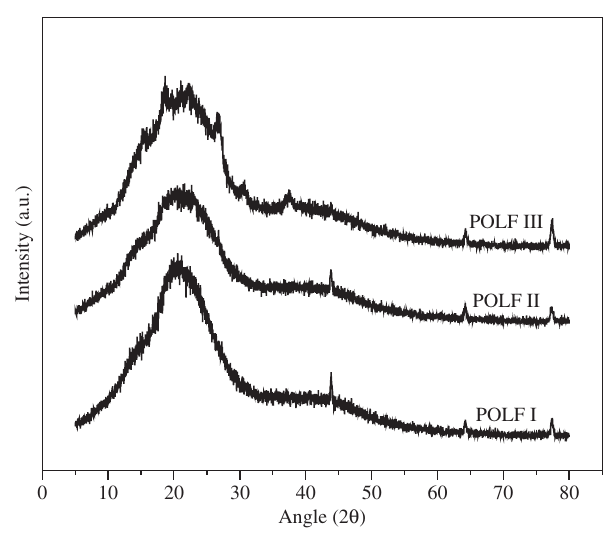
Figure 5. X ray powder diffraction from POLF